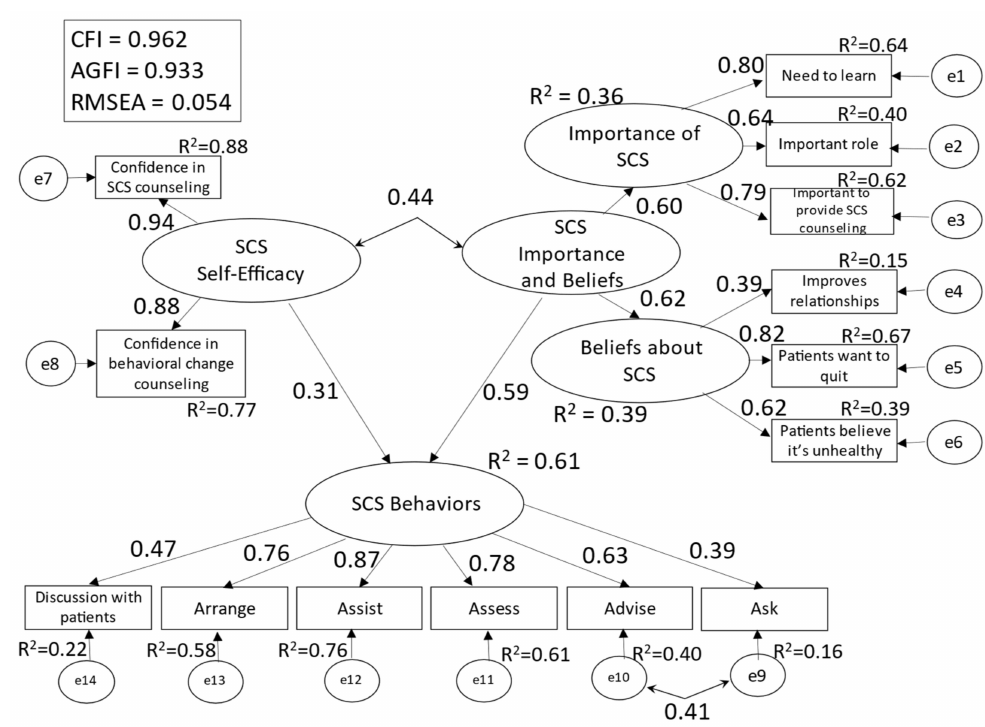
Figure 1. Conceptual Model 2 (all participants).